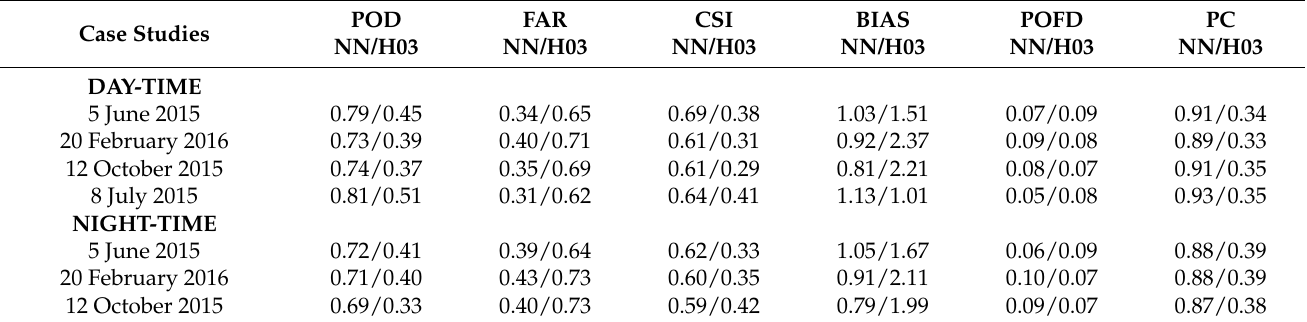
Table 11. Dichotomous scores for neural network technique (NN) and PR-OBS-3A (H03)